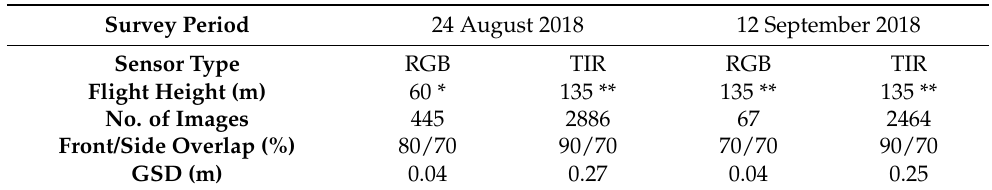
Table 1. Characteristics of the flight campaigns. Flight height is referred to the take ‐ off point for the RGB sensor. GSD: ground sample distance.